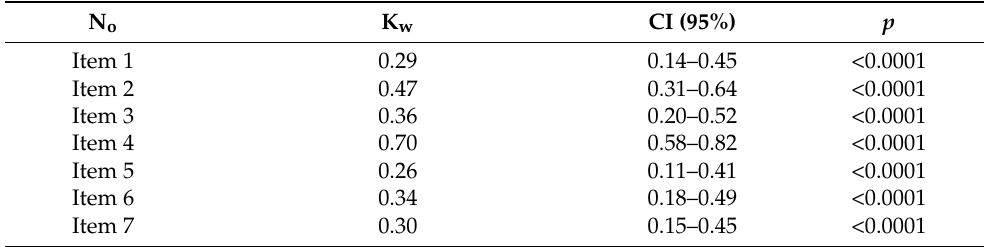
Table 3. Results of the analysis of internal consistency and test-retest reliability of Movement Imagery Questionnaire-3